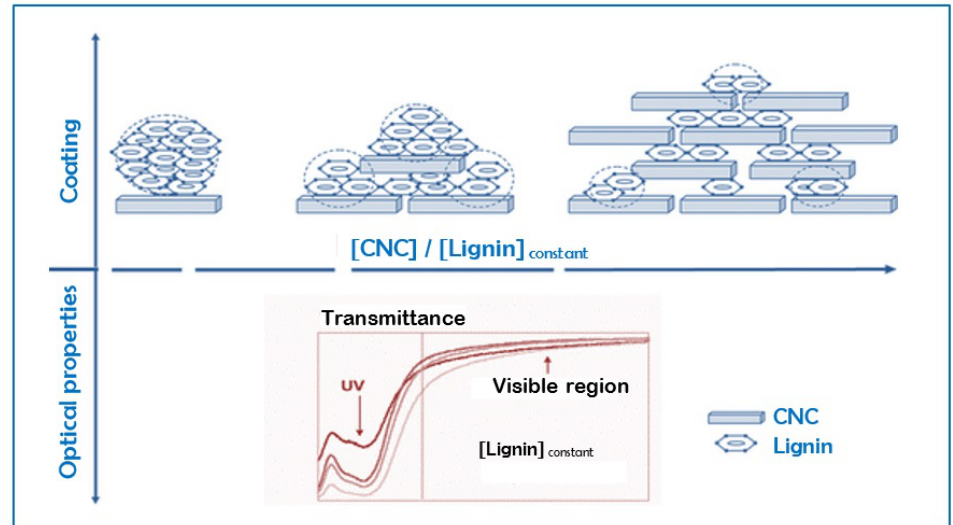
Figure 8. Illustration of the structural arrangement of CNC/lignin nanocomposite coatings and UV-transmittance. Reprinted (adapted) with permission from [31], copyright (2016) American Chemical